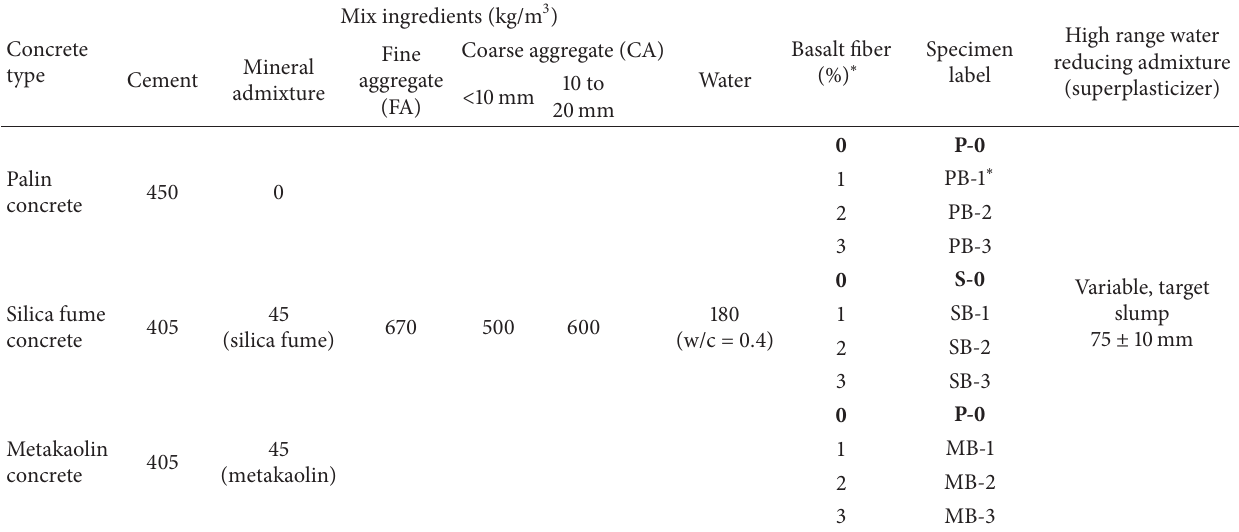
Table 4: Mixture proportion of the HPFRC